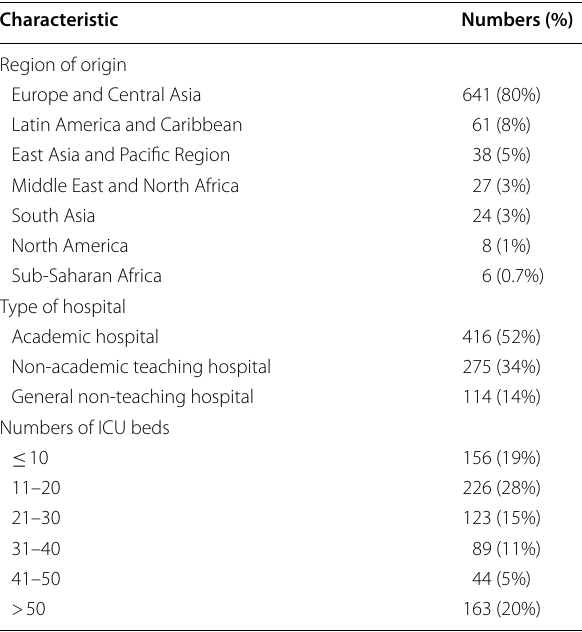
Table 1 Demographic